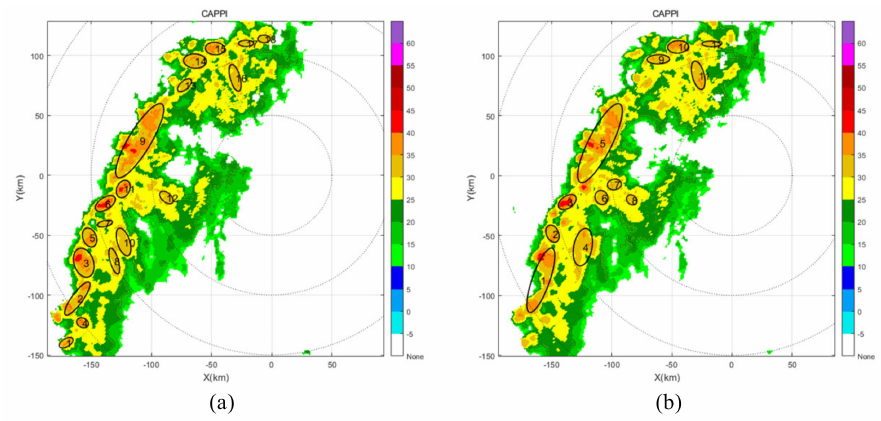
Figure 12. ( a ) TITAN algorithm recognition result at t3 and ( b ) TITAN algorithm recognition result at t4.